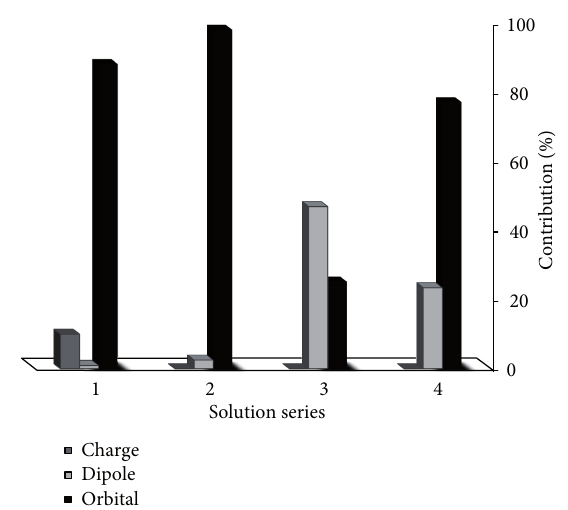
F 3: A comparison among three electronic parameters of charge, dipole, and orbital energy contributed in evaluation of acidity of phenol derivatives in four different categories of their solvation in solvent of methanol/water. e numbers 1, 2, 3, and 4